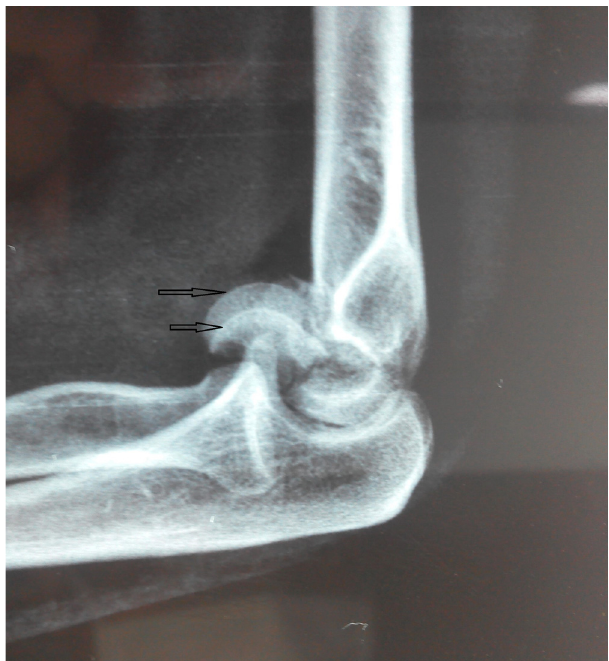
Figure 2. Classical double arc sign signifying involvement of trochlea in the coronal fracture.